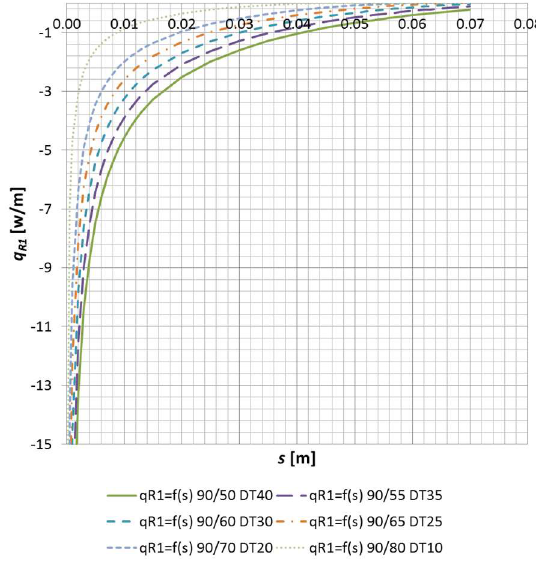
Figure 2. Unit heat flux transferred from the supply pipe to the return pipe as a function of the distance between the conductors at different return temperatures ( q R 1 = f(s,T R ) ).